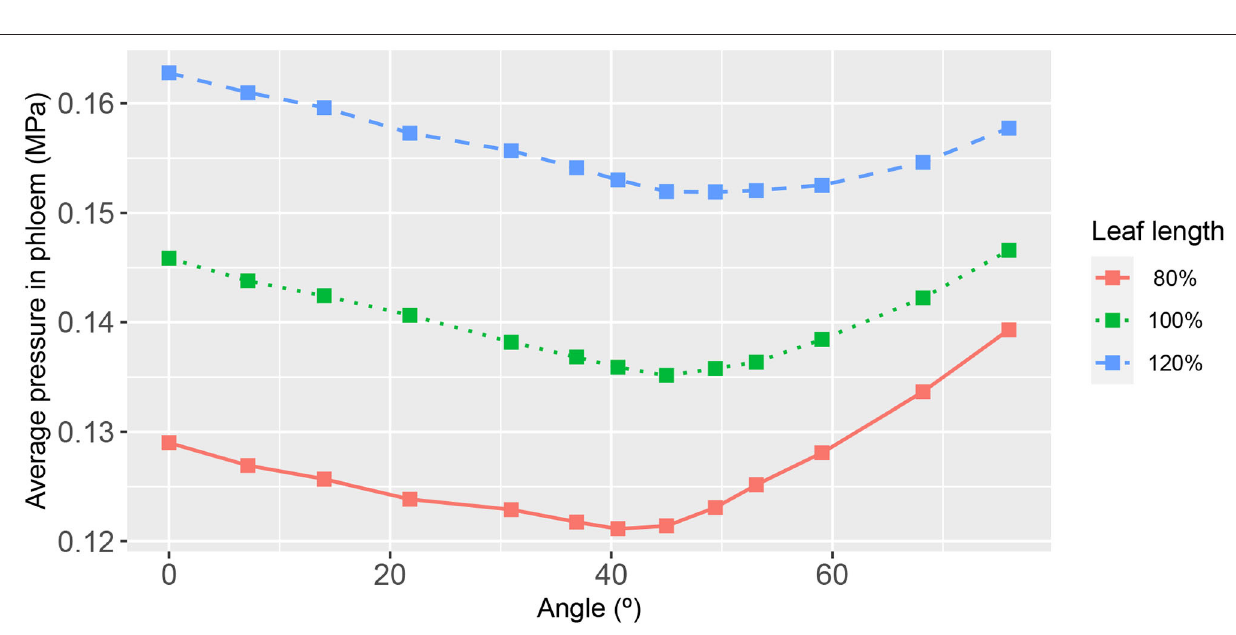
hydraulic pressure followed suit. Somewhat unsurprisingly, increasing the conductances of the higher order veins, such as fifth order veins ( Supplementary Figure 9 ), demonstrates a weakening of the influence of the 2 nd order veins. As higher order veins become more conductive the dependence of the 2 nd order vein angle becomes less pronounced since the